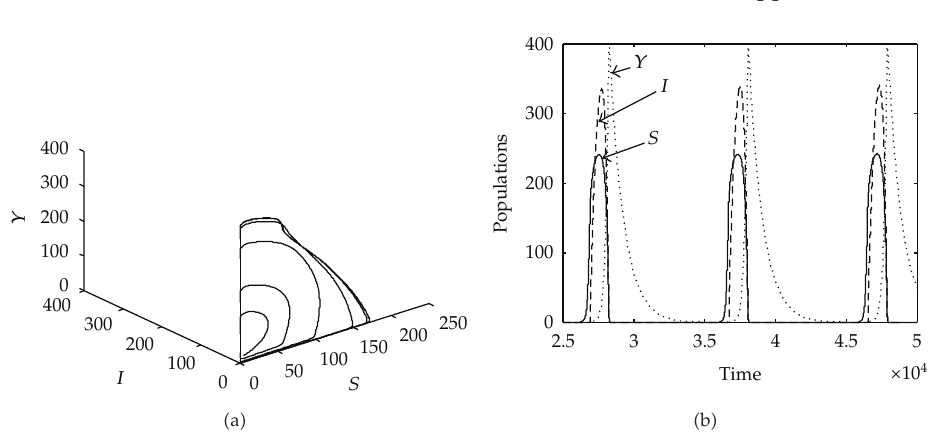
Figure 3: (cid:5) a (cid:6) System (cid:5) 2.1 (cid:6) approaches periodic attractor in Int. R 3 (cid:7) for λ (cid:8) 0 . 5 with the rest of parameters are given by (cid:5) 6.1 (cid:6) . (cid:5) b (cid:6) Time series of the trajectory in (cid:5) a (cid:6) .